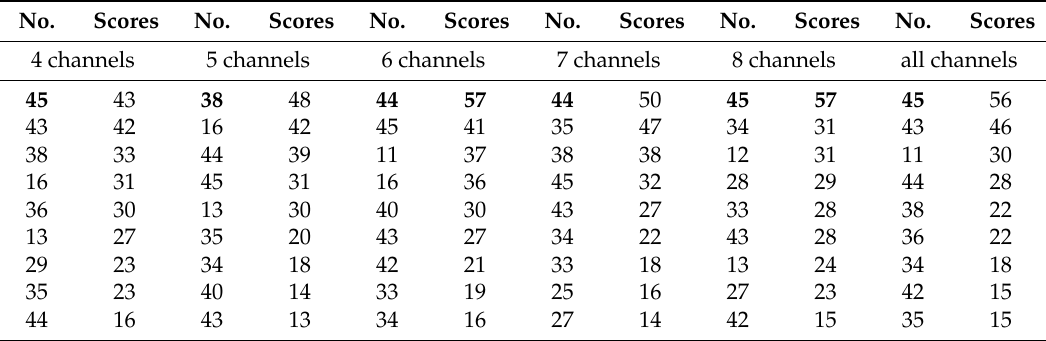
Table 2. Cumulative scores of the nine best-performed filter sets or series under CIE standard illuminant D65.